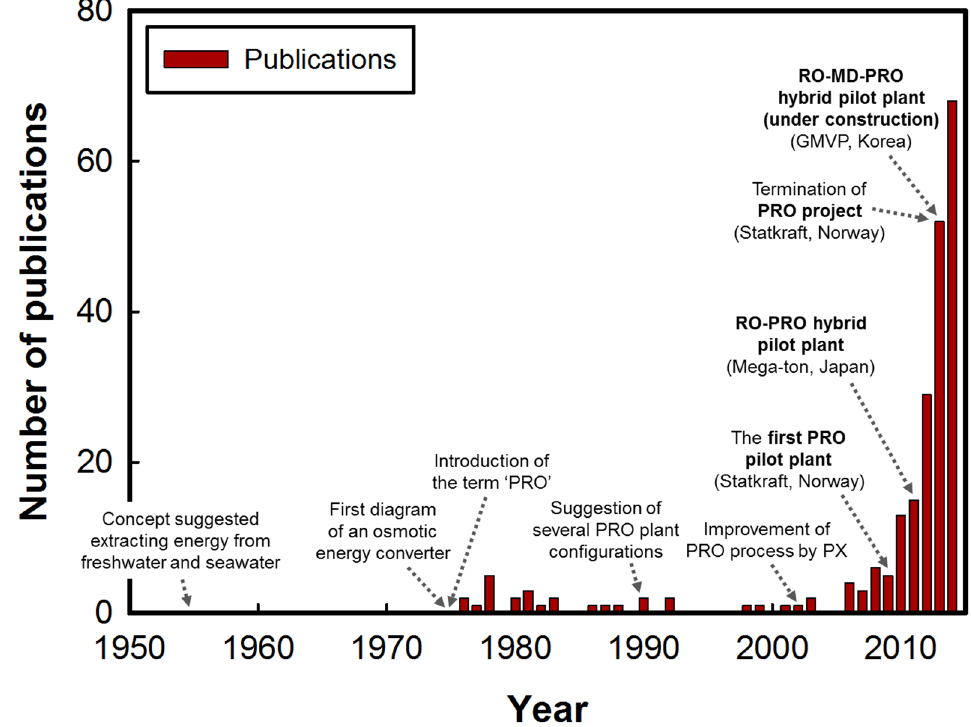
Figure 3. Key developments of the PRO process. Increased attention in PRO is shown by the number of PRO publications collected via